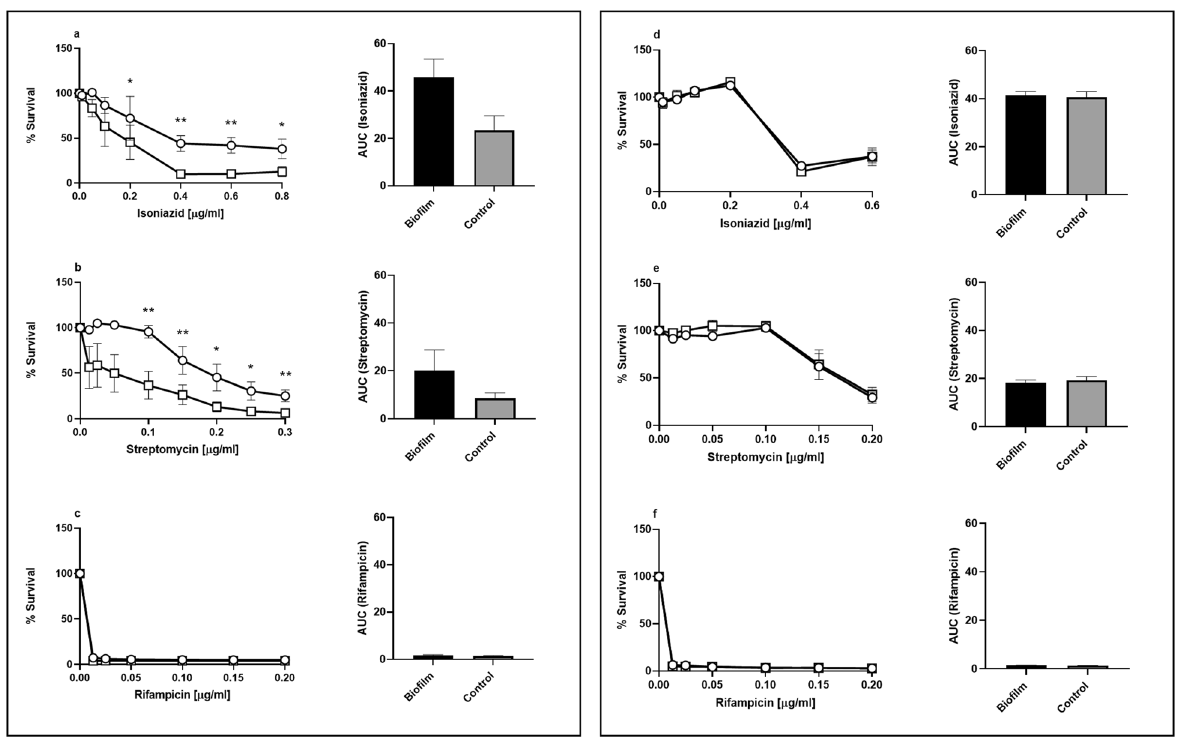
Fig. 3 Bio fi lm-derived bacilli are tolerant to isoniazid and streptomycin. a – c RCCS-bio fi lm (circle) or non-rotating control (square) bacilli were homogenised to single cell suspensions and exposed to isoniazid, streptomycin or rifampicin. Bio fi lm-derived bacilli showed enhanced survival to isoniazid and streptomycin, but not rifampicin. d – f This drug tolerant phenotype was lost after passage in drug-free media. Area under the curve (AUC) plots illustrating the difference in drug ef fi cacy over multiple drug concentrations are detailed alongside each plot. Percentage survival calculated relative to untreated bacilli. Error bars are ±standard error of the mean from two biological replicates each with duplicate technical replicates. * p value ≤ 0.05; ** p value ≤